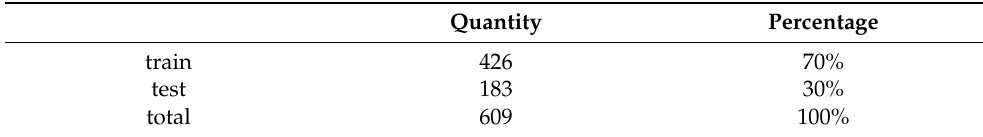
Table 4. Partitioning of the training set and test